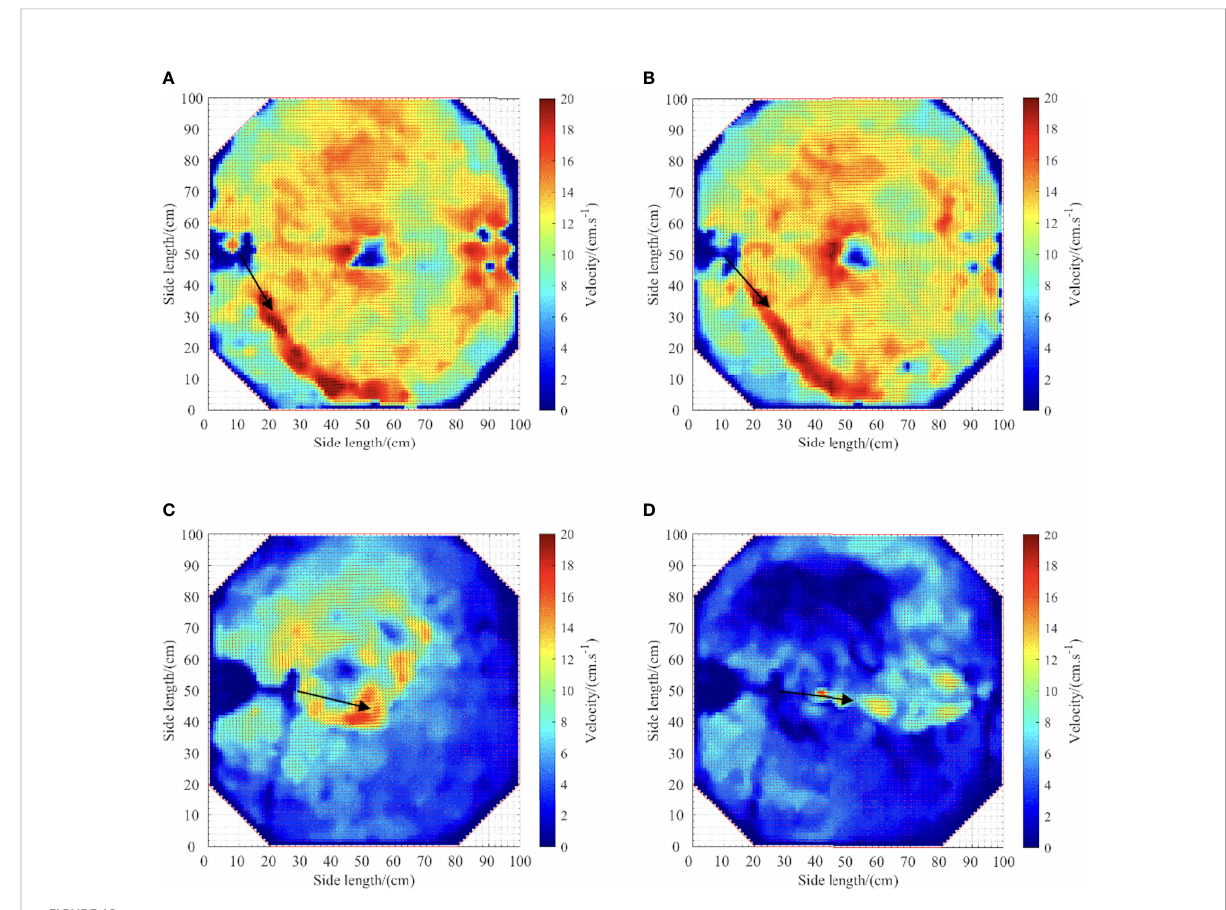
FIGURE 12 Flow fi eld contours in a single-inlet aquaculture tank: (A) d / a =1/8; q =30°; (B) d / a =1/8; q =40°; (C) d / a =1/4; q =70°; (D) d / a =1/4; q =80°.